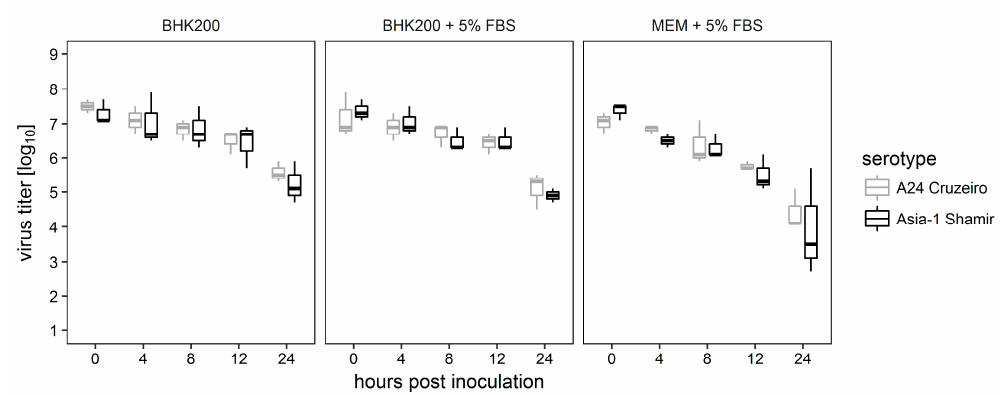
Figure 1. Storage of FMDV A 24 Cruzeiro and Asia-1 Shamir in different culture media for 24 h. Equal amounts of virus were incubated in serum-free Cellvento™ BHK200 media, Cellvento™ BHK200